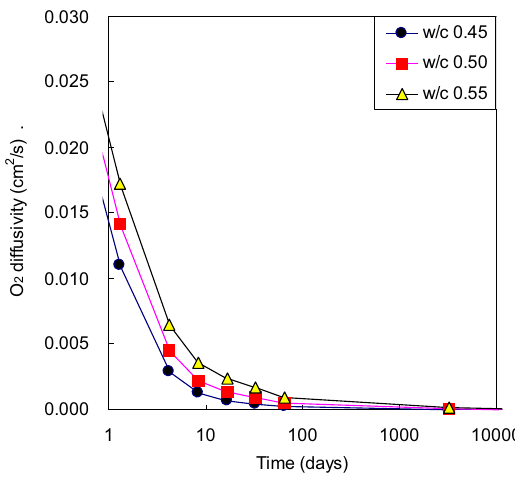
Fig. 10 Effective oxygen diffusivity of carbonated concrete.